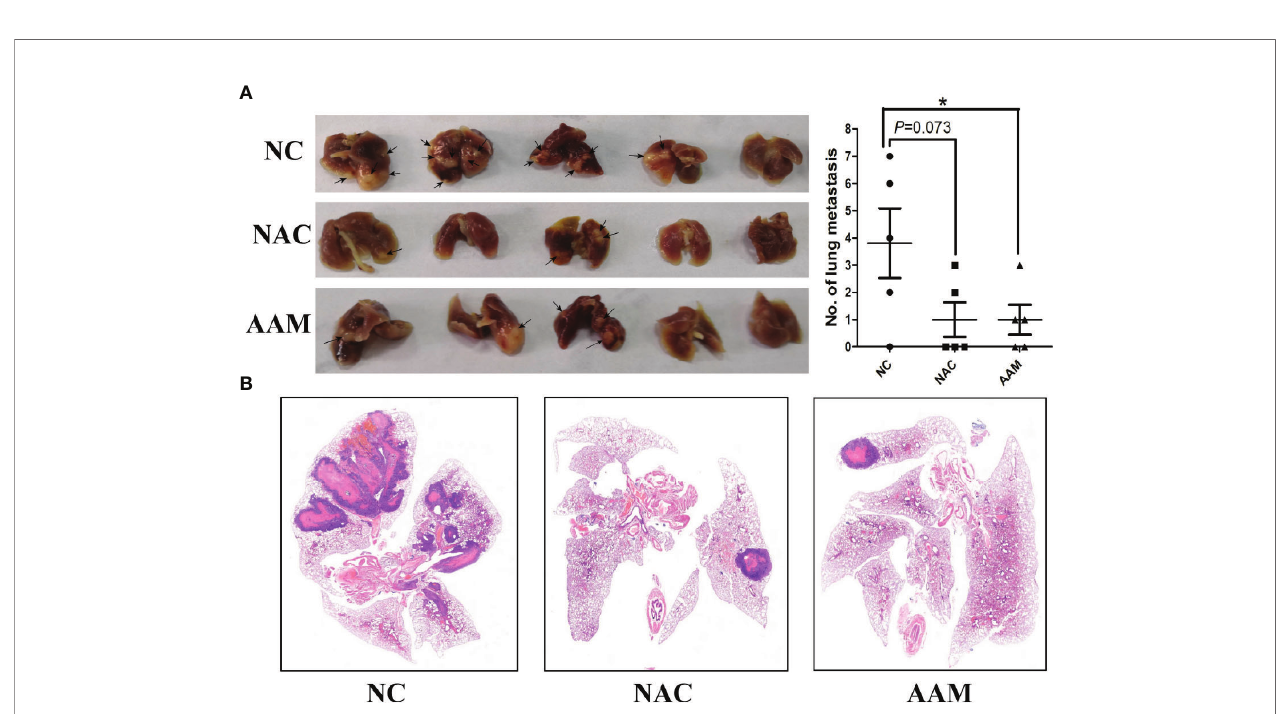
FIGURE 11 | AAM inhibits metastasis of colorectal cancer in vivo . (A) Representative pictures of lungs of NAC, AAM treated and control groups; the number of metastatic tumor nodules on the surface of the lungs was counted (Right side). (B) HE staining was used to determine the metastatic lesions. (* P <